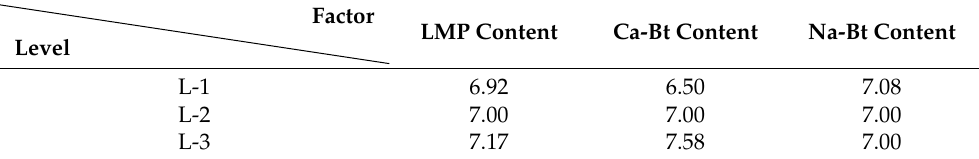
Table 2. Values of k i , j for gelation.